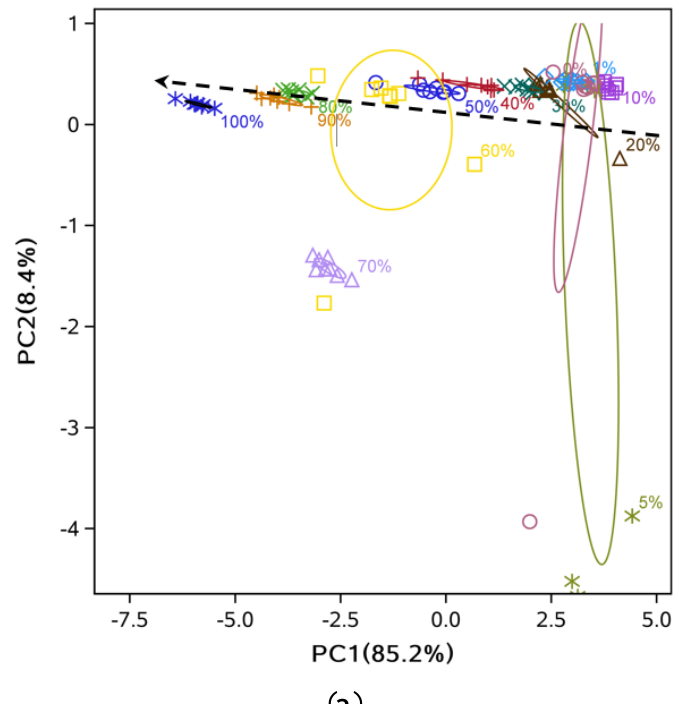
Figure 3. PC1 and PC2 score plot from PCA analysis for sesame oil mixed with soybean oil. ( a ) hot-pressed oil mixed with refined soybean oil; ( b ) cold-pressed oil mixed with refined soybean